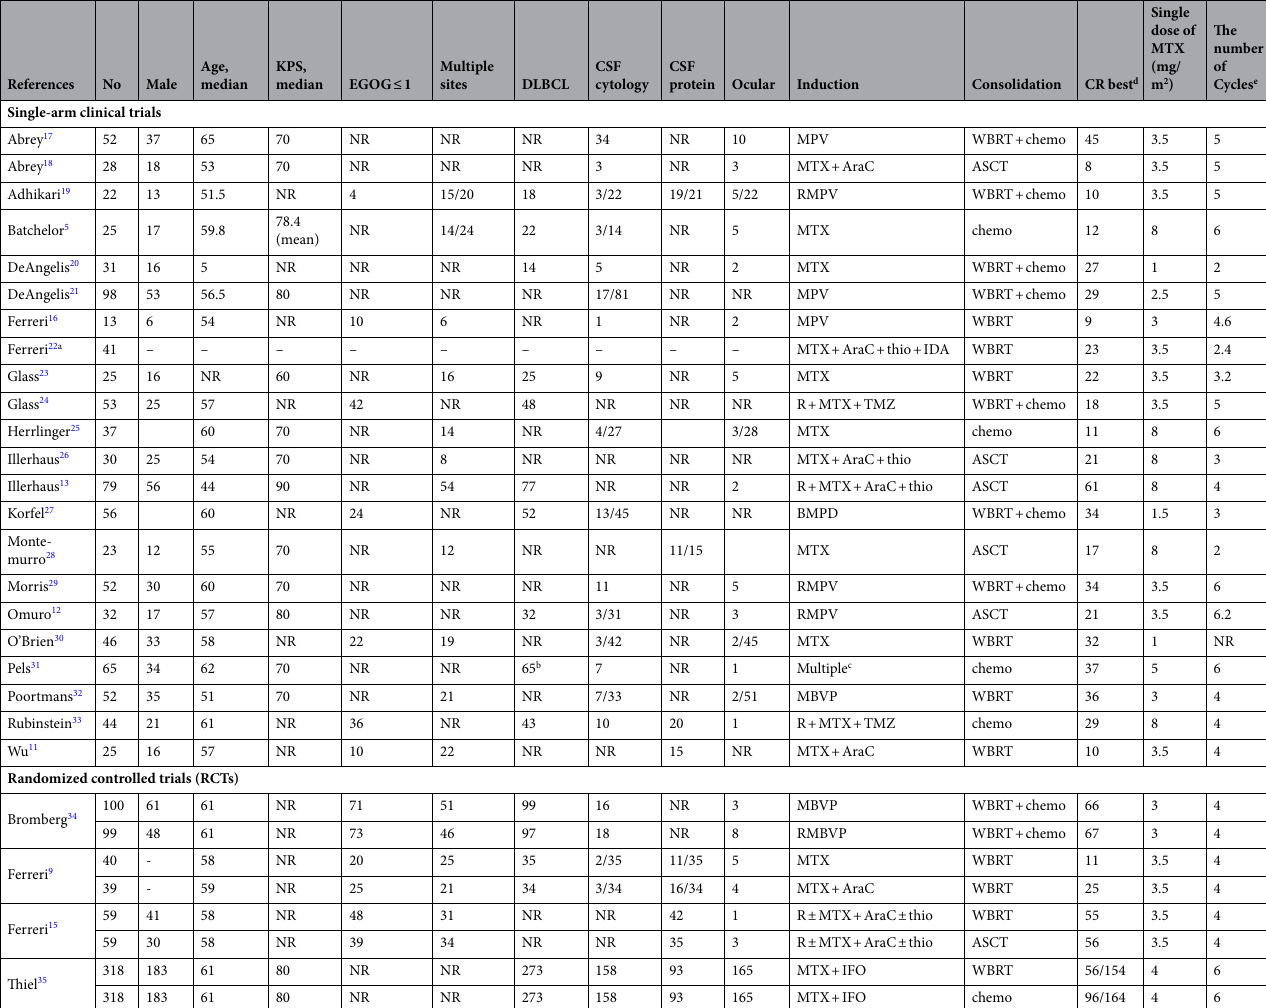
Table 1. Characteristics of the included studies. MTX (M) methotrexate, AraC cytarabine, IDA idarubicine, IFO ifosfamide, B carmustine (BCNU), P procarbazine, V vincristine, R rituximab, TMZ temozolomide, thio thiotepa, WBRT whole-brain radiotherapy, ASCT autologous stem cell transplantation, chemo chemotherapy, NR not reported. a Patients’ characteristics information is not available in the supplementary material. b B-cell origin. c Including high-dose methotrexate, cytarabine, vinca-alkaloids, ifosfamide, and cyclophosphamide. d The best CR number mentioned in the study; some are CR patients after inductive chemotherapy; some are after the completion of the consolidation treatment. e The number of cycles given in inductive treatment which containing